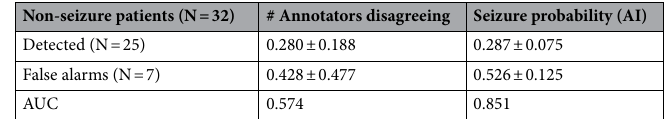
Table 3. Average ± CI95 for AI probability for correctly detected seizures and missed